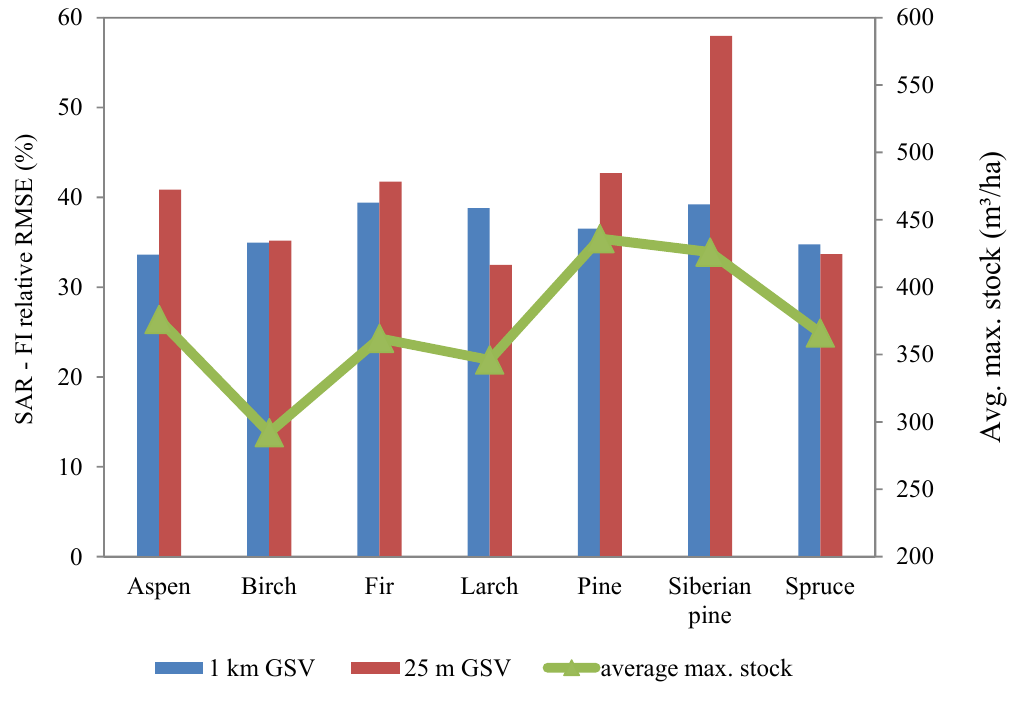
Figure 4. Relative RMSE of SAR—forest inventory comparisons of dominant forest species (mean values of all test sites); the 1 km GSV map better matches with FI in the high biomass levels and vice